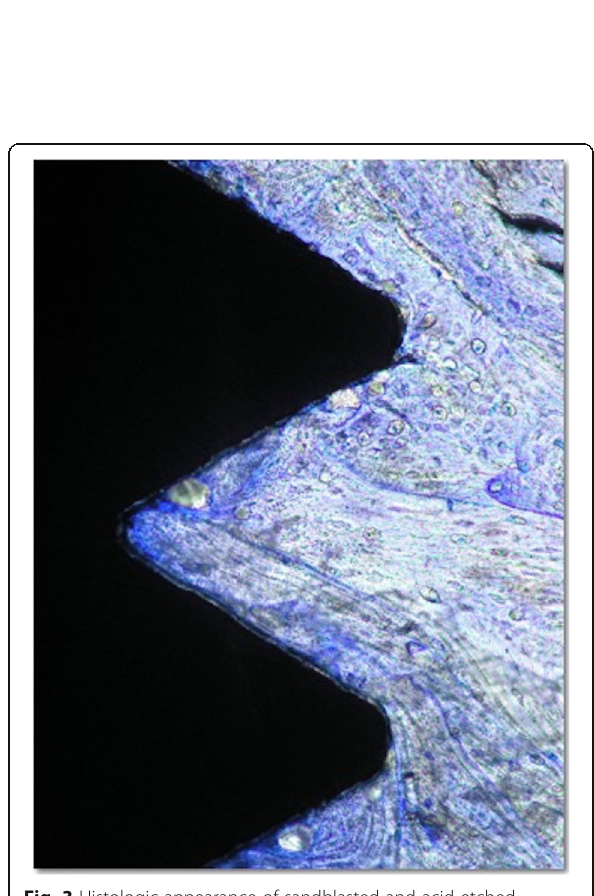
Fig. 3 Histologic appearance of sandblasted and acid-etched implant. Direct bone contact with well-organized bone and lamellar apposition is